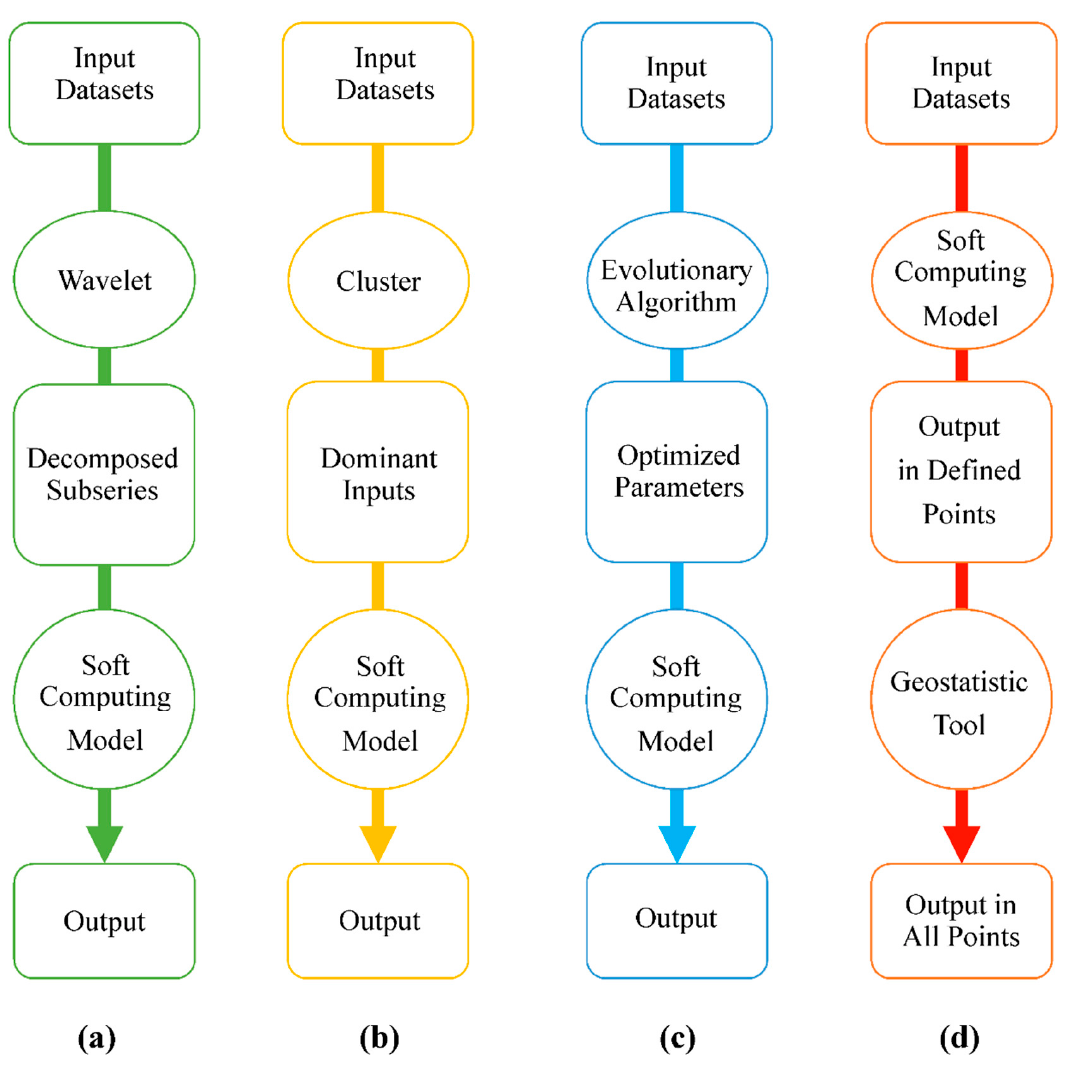
Figure 8. Schematic of common hybrid soft computing methods for seepage modeling. ( a ) Wavelet ‐ soft computing methods; ( b ) cluster ‐ based soft computing methods; ( c ) evolutionary ‐ soft computing methods; ( d ) soft computing geostatistic ‐ based methods.